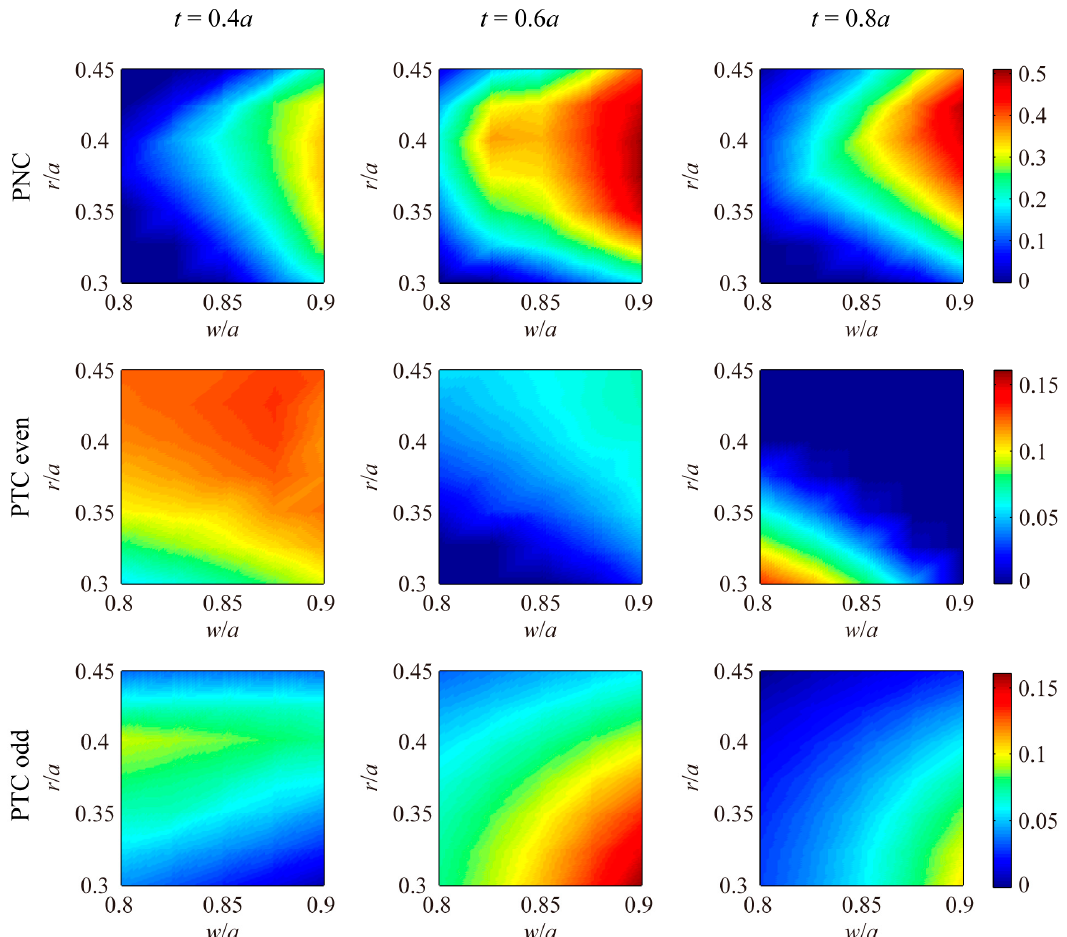
Figure 2. Variations of the gap-to-midgap ratio of phononic (top row), photonic even (middle row), and odd (bottom row) modes as functions of cylinder radius r and hole width w with different slab thicknesses. The results of three slab thicknesses t = 0.4 a (left column), 0.6 a (middle column), and 0.8 a (right column) are plotted.